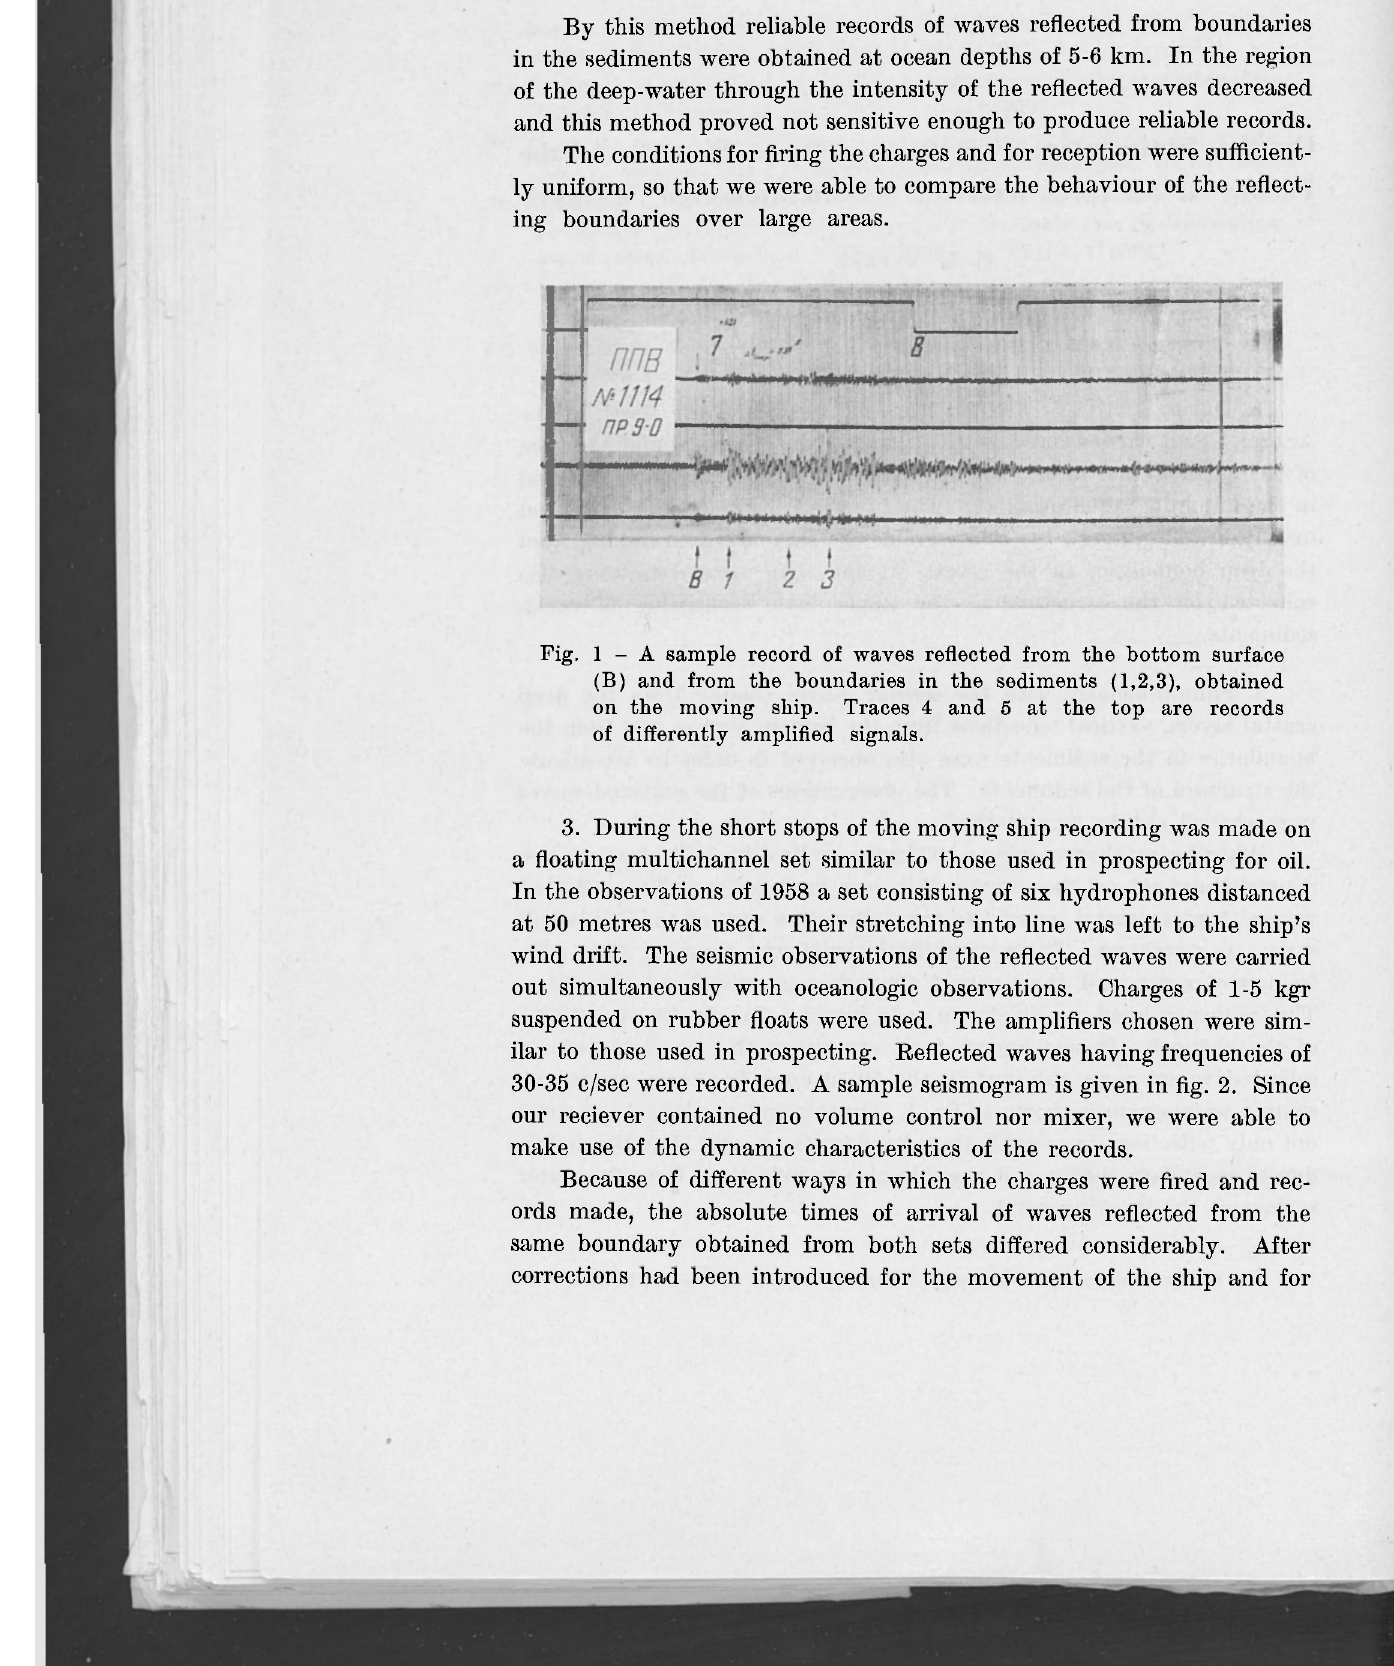
Fig. 1 - A sample record of waves reflected from the bottom surface (B) and from the boundaries in the sediments (1,2,3), obtained on the moving ship. Traces 4 and 5 at the top are records of differently amplified